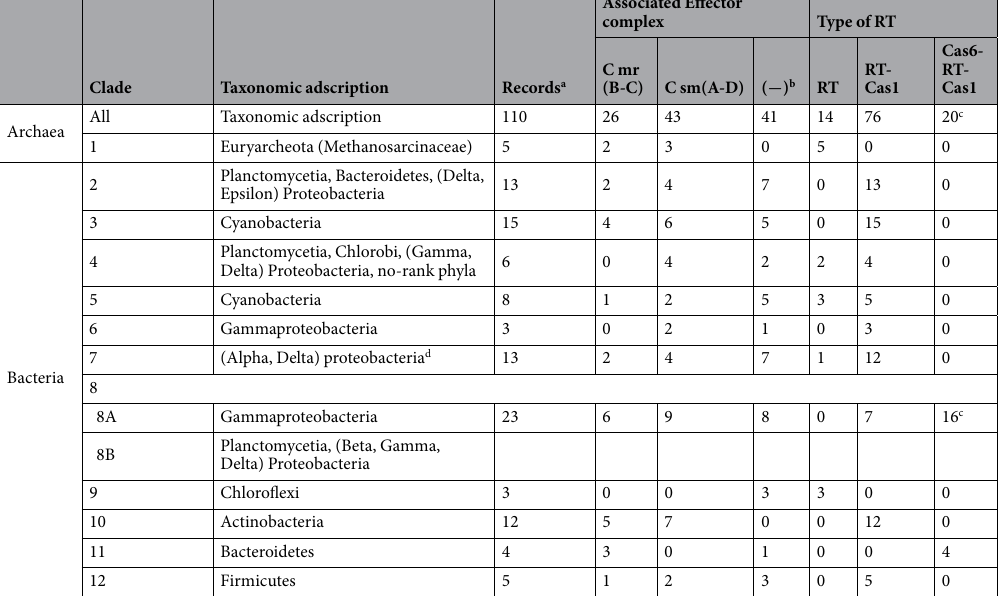
Table 1. Distribution of RTs associated with CRISPR-cas systems. (a) Number of representative RTs described in this study ( ≤ 85% identity) corresponding to Tables S1–S12. (b) N o records with partial or unknown effector complex associated. (c) One of the records corresponds to a Cas6-RT fusion gene without a recognizable Cas1 domain. (d) 92% of the records belong to Alphaproteobacteria